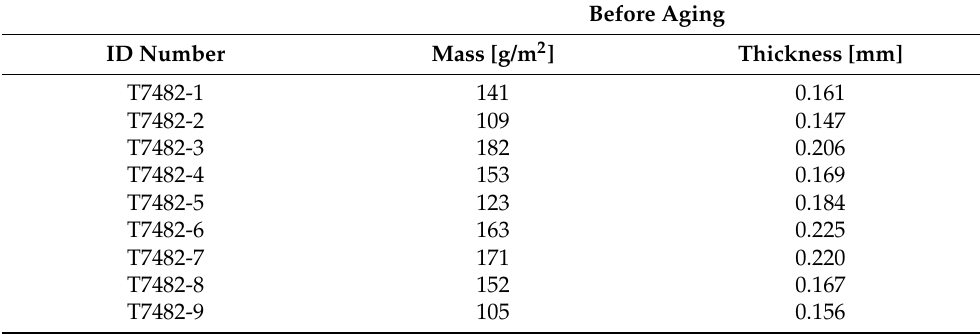
Table 7. Thickness and mass before aging.